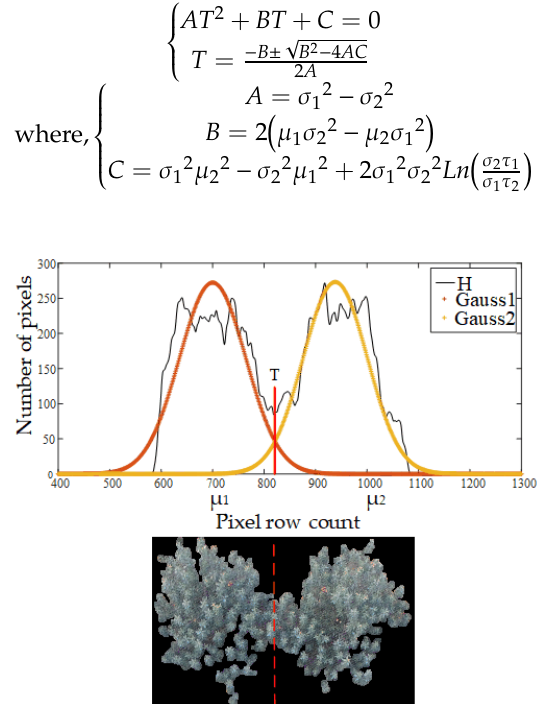
Figure 10. An example of a threshold for image segmentation.